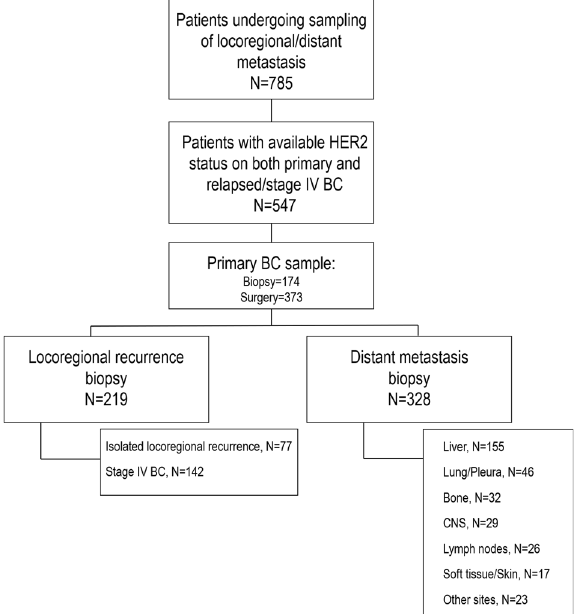
Fig. 1 Flow diagram of the study. N number, BC breast cancer, CNS central nervous system.